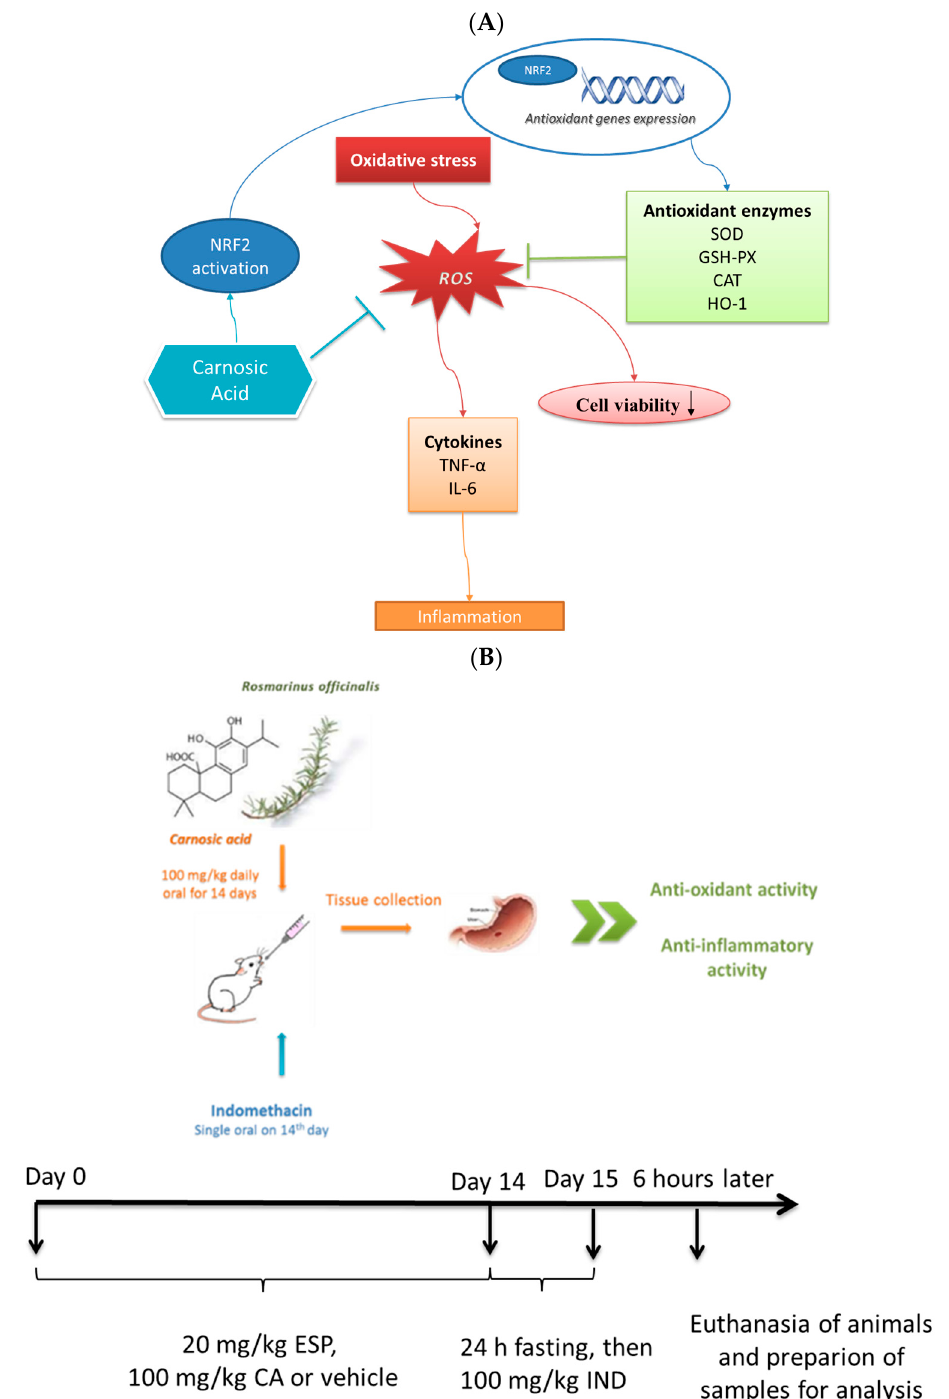
Figure 1. ( A ) Putative Mechanism of CA Action. ( B ) Diagram showing the design and time-course of experimental procedures (ESP, Esomeprazole at 20 mg/kg; vehicle, distilled water (98%); CA, Carnosic acid at 100 mg/kg; IND, Indomethacin at 100 mg/kg). All drugs were administrated by oral gavage. Data are reported as seven animals per group.